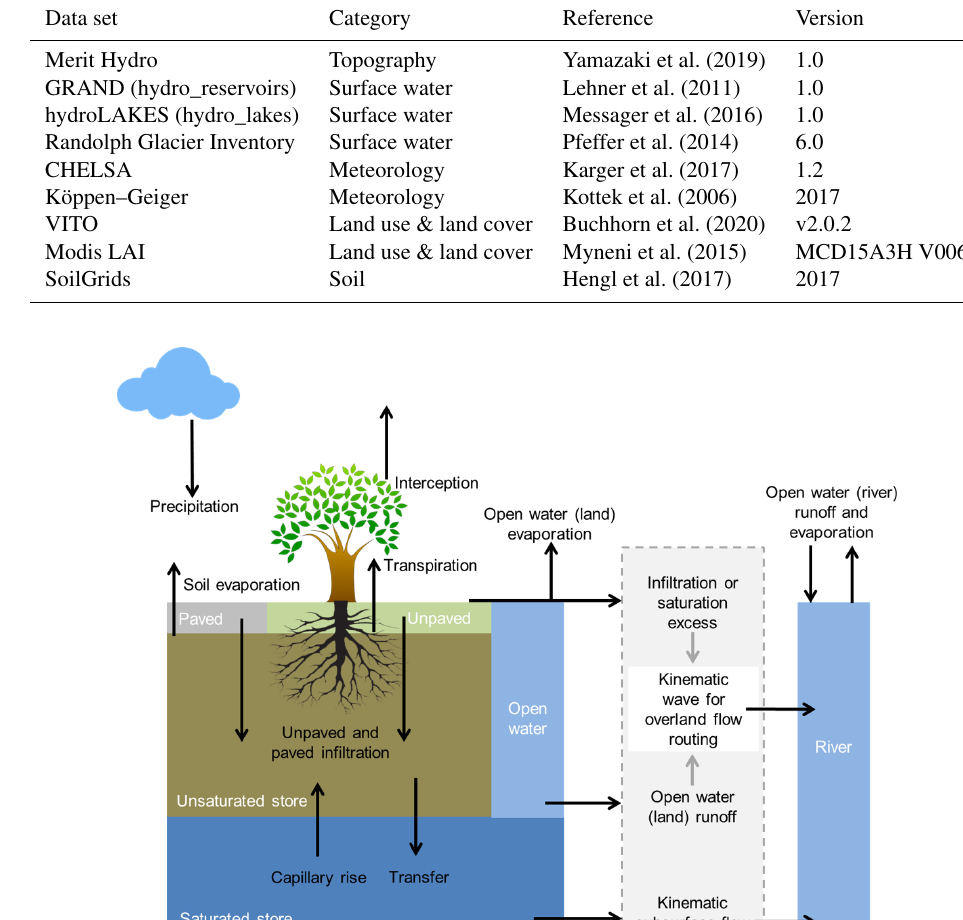
– vertical transfer of water that is controlled by the sat- urated hydraulic conductivity at the water table or bot- tom of a layer, the relative saturation of the layer, and a power coefficient depending on the soil texture (Brooks and Corey,